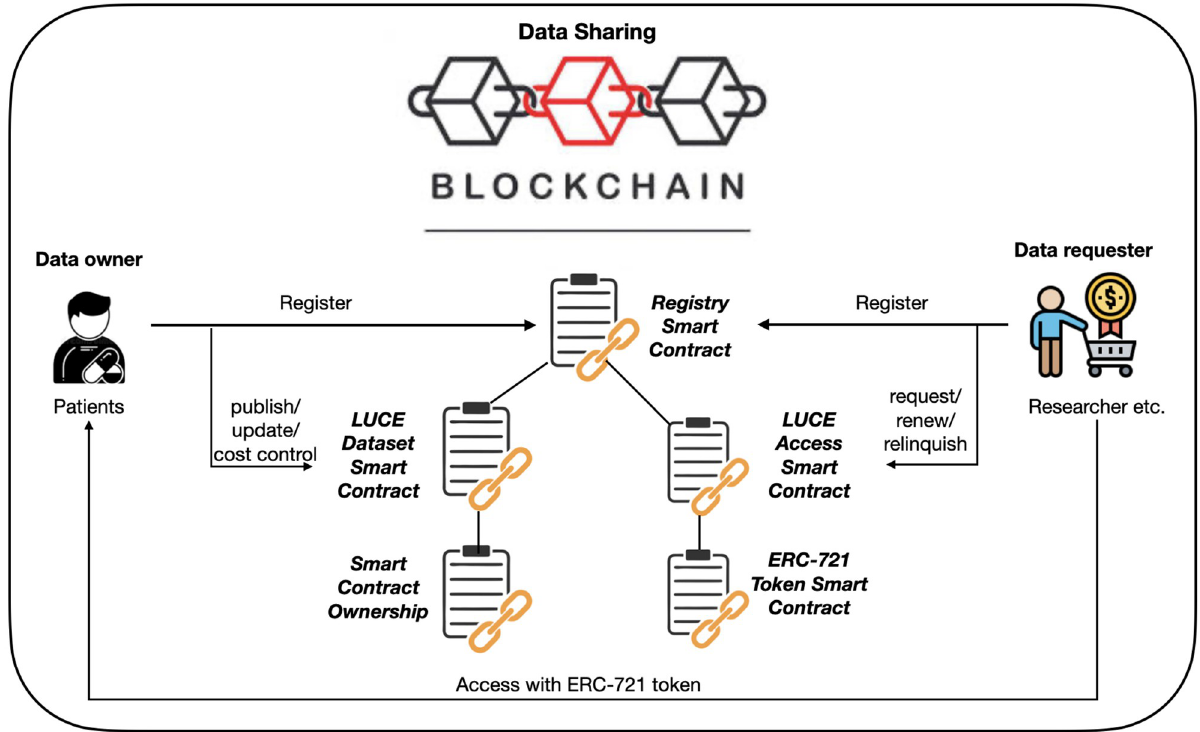
Fig 1. Incentive architecture for a blockchain-based data sharing platform.